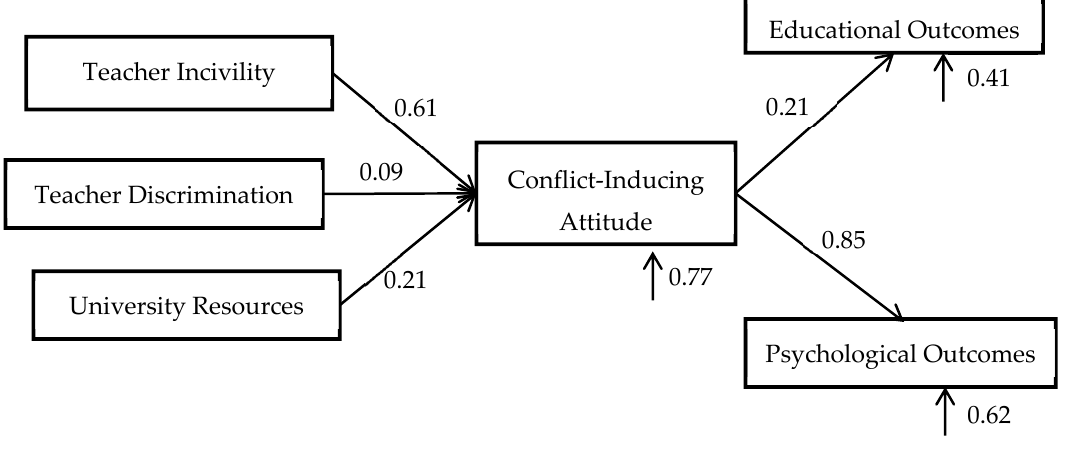
Figure 2. Tested model in our study.